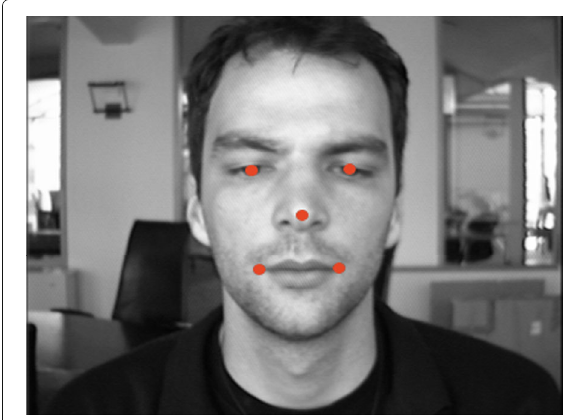
Fig. 7 5 point landmark configuration. The landmark configuration used by Sun et al. [62]